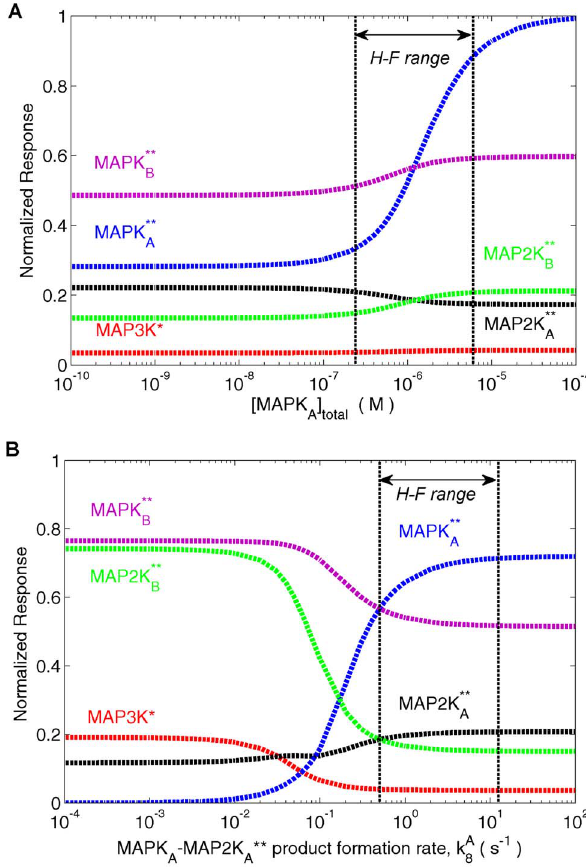
Figure 4. The branched MAPK cascade responds differently to to distinct perturbations which inhibit the activation of a terminal kinase in one branch. The normalized response, i.e., the ratio of activated to total kinase concentration, of different molecular species in the reaction cascade when (A) the total concentration of ) of MAPK A MAPK A is varied and (B) when the product formation rate ( k A 8 is varied shows opposing behavior in the activity of molecules in the unperturbed B branch, although both types of perturbations have the same functional goal of decreasing the activation of MAPK A . As [MAPK A ] total is decreased, both MAPK B and MAP2K B decrease in activity. However, when the product formation rate of MAPK A is decreased, the activity of both MAPK B and MAP2K B are increased. The activity of the kinase MAP3K which forms the branch-point also shows different response to the two perturbations unlike the result for single-branch cascades: in (A), the activity is unchanged, whereas in (B), the activity of MAP3K increases, on decreasing the activation of MAPK A . Note that the curves corresponding to MAPK A and MAPK B intersect in (A) when [MAPK A ] total =[MAPK B ] total =1.2 m M and they intersect in (B) when the product formation rates for MAPK A and MAPK B , i.e., k A and k B 8 8 respectively, are both 0.5 s 2 1 . Except for [MAPK A ] total and k A , all other 8 total molecular concentrations and reaction rates are kept fixed at the values given in Table S1. The broken lines indicate the physiologically in (B), as used in plausible range of values for [MAPK A ] total in (A) and k A 8 the Huang-Ferrell model [45]. ments additionally show that under perturbation, the retrograde propagation from JNK to p38MAPK is significantly higher than from p38MAPK to JNK (Table 1). Plausible reasons for this could lie in the asymmetry of the molecular concentration values and/or the reaction parameters in the two branches. Thus, we next analyze the effect of such asymmetry on the retrograde propaga- tion of information.